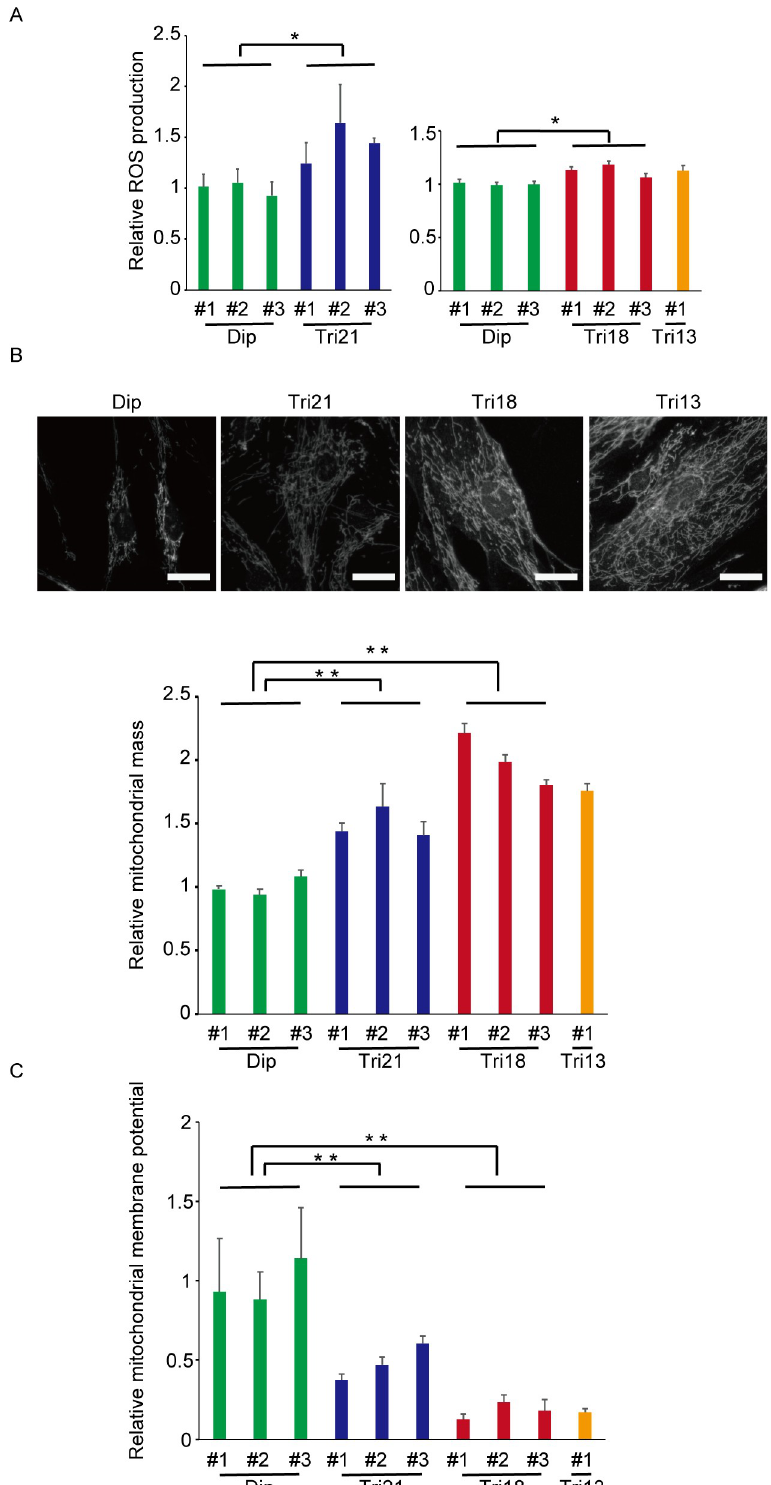
Fig 4. Trisomy fibroblasts showed increased oxidative stress and accumulation of damaged mitochondria. (A) Relative ROS production as expressed by relative MitoSOX/MitoTracker ratio (n = 5–6 per cell line). � P < 0.05. Dip, diploid; Tri, trisomy. (B) Relative mitochondrial mass per cell as assessed by average TOM20-positive area per cell. The